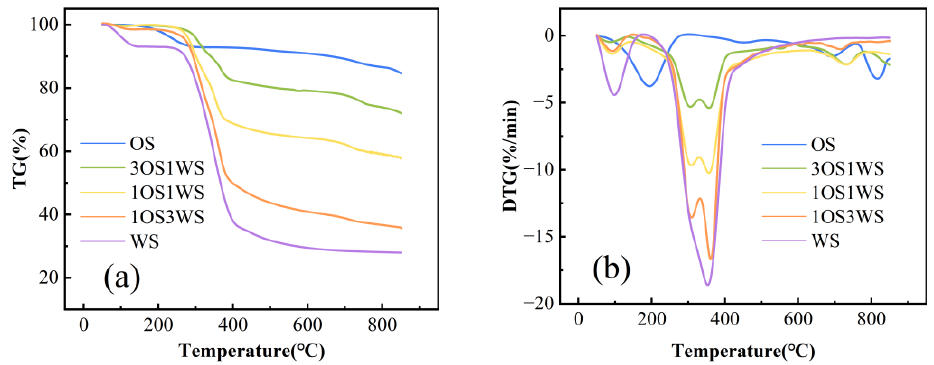
Figure 3. TG curves of ( a ) OS, ( b ) WS, ( c – e ) their mixtures, and ( f – h ) mixture with catalysts at different heating rates.